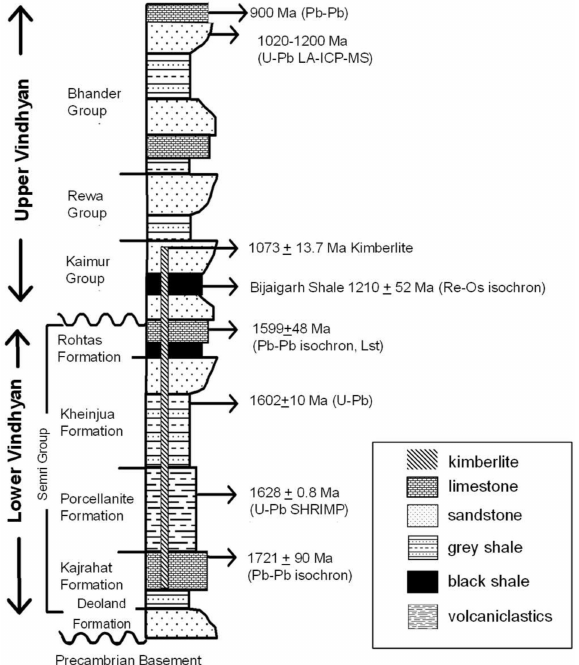
Figure 2. A generalised stratigraphic column of the Vindhyan Supergroup showing the major geochronologic data and the position of the Bijaigarh shale in the Upper Vindhyan sequence modified after